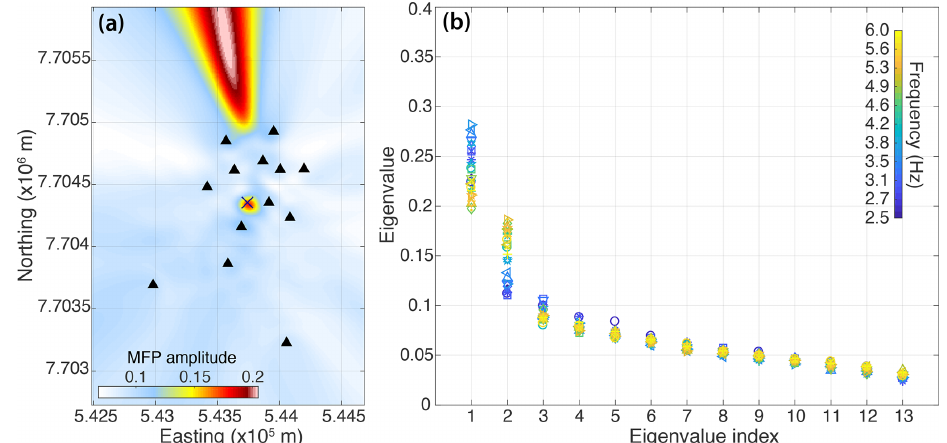
Figure 7. (a) Location of the dominant noise sources using MFP in the frequency band between 2.5 and 6Hz (the MFP output is averaged over 30 discrete frequencies). The MFP was calculated using daily data recorded on 27 July at the 13 presented stations (black triangles). Blue cross indicates the moulin position. (b) Eigenvalue distribution of the CSDM for 30 discrete frequencies in the analyzed frequency